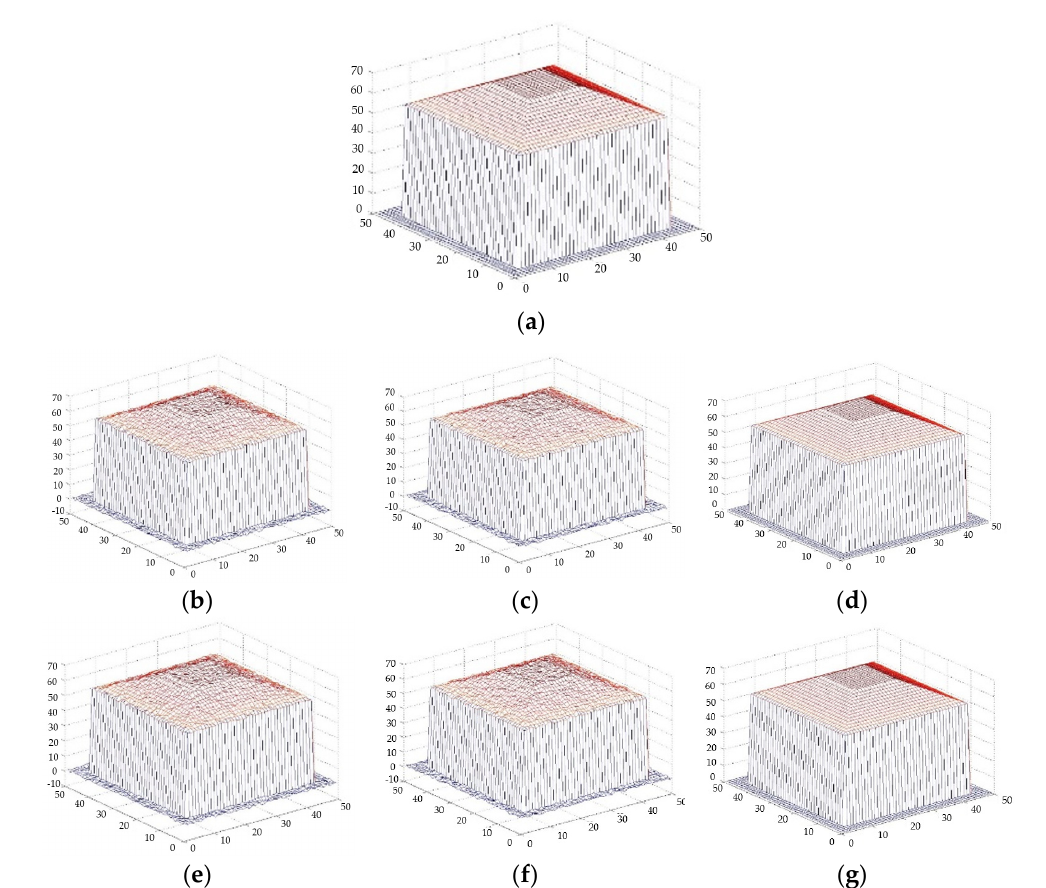
Figure 5. Comparison of the effect before and after the fusion of pitched-roofed buildings with different variance Gaussian noise. ( a ) DSM of the truth map for pitched-roofed building. ( b ) DSM 1 variance 0.1. ( c ) DSM 2 variance 0.1. ( d ) DSM after